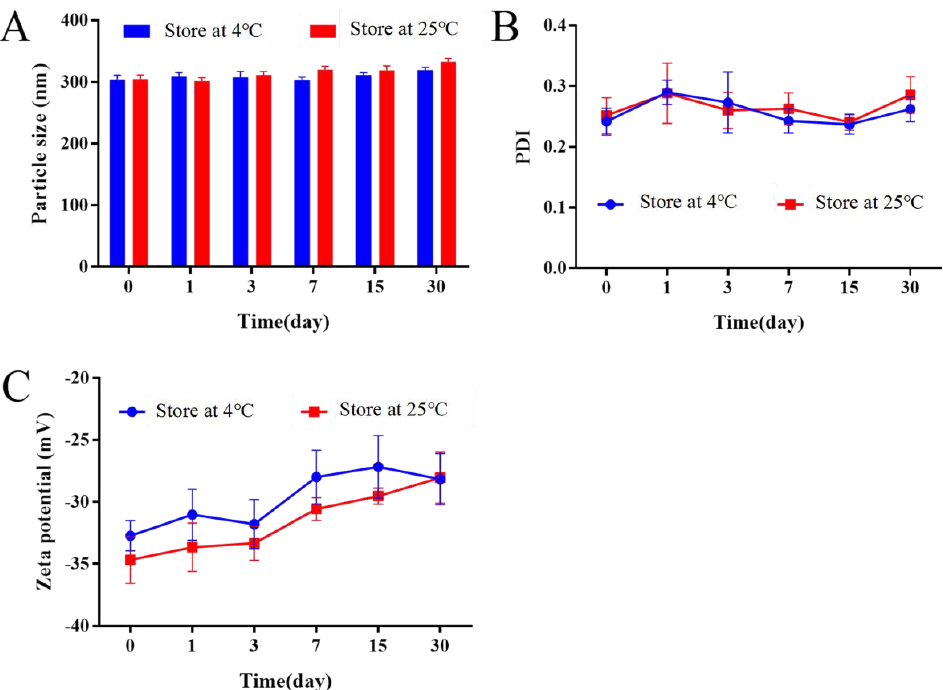
Figure 10. Changes in the particle size ( A ), PDI ( B ) and zeta potential ( C ) of Bre-NS stored at 4 ◦ C or 25 ◦ C and for a different duration (mean ± SD, n = 3).